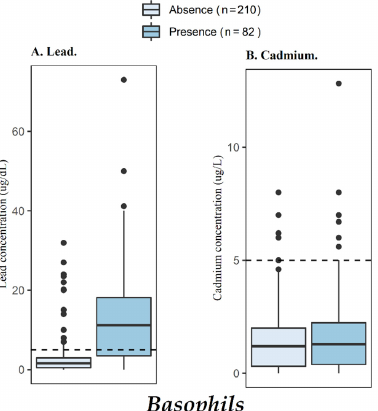
Figure 1. Association between basophil blood cell counts and Pb and Cd concentrations in whole blood. The dotted line indicates the recommended safe limits for Pb and Cd concentrations in whole blood [13].